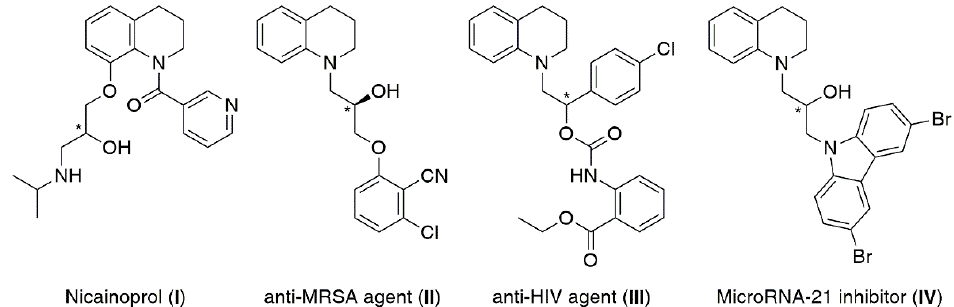
Figure 1. Examples of pharmaceutical ( I ) and biologically active compounds ( II – IV ) incorporating 1,2,3,4-tetrahydroquinoline scaffold. The center of asymmetry was marked by the asterisk symbol (*).